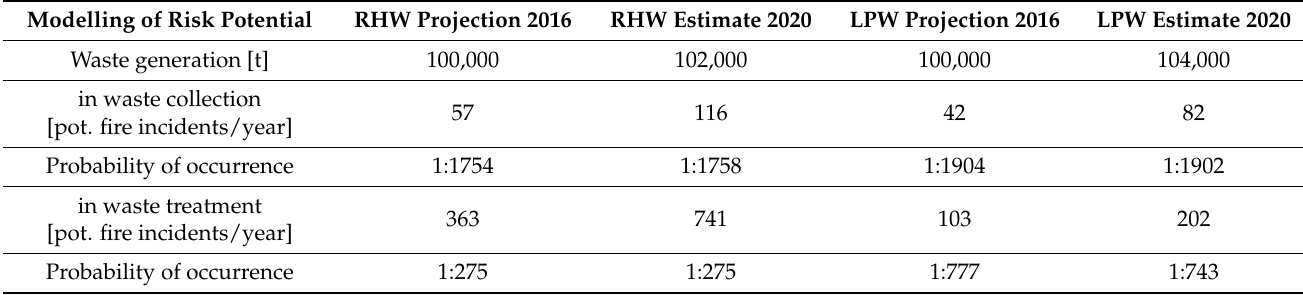
Table 8. Risk modelling for portable and lithium-based batteries in residual household waste (RHW) and lightweight packaging waste (LPW).